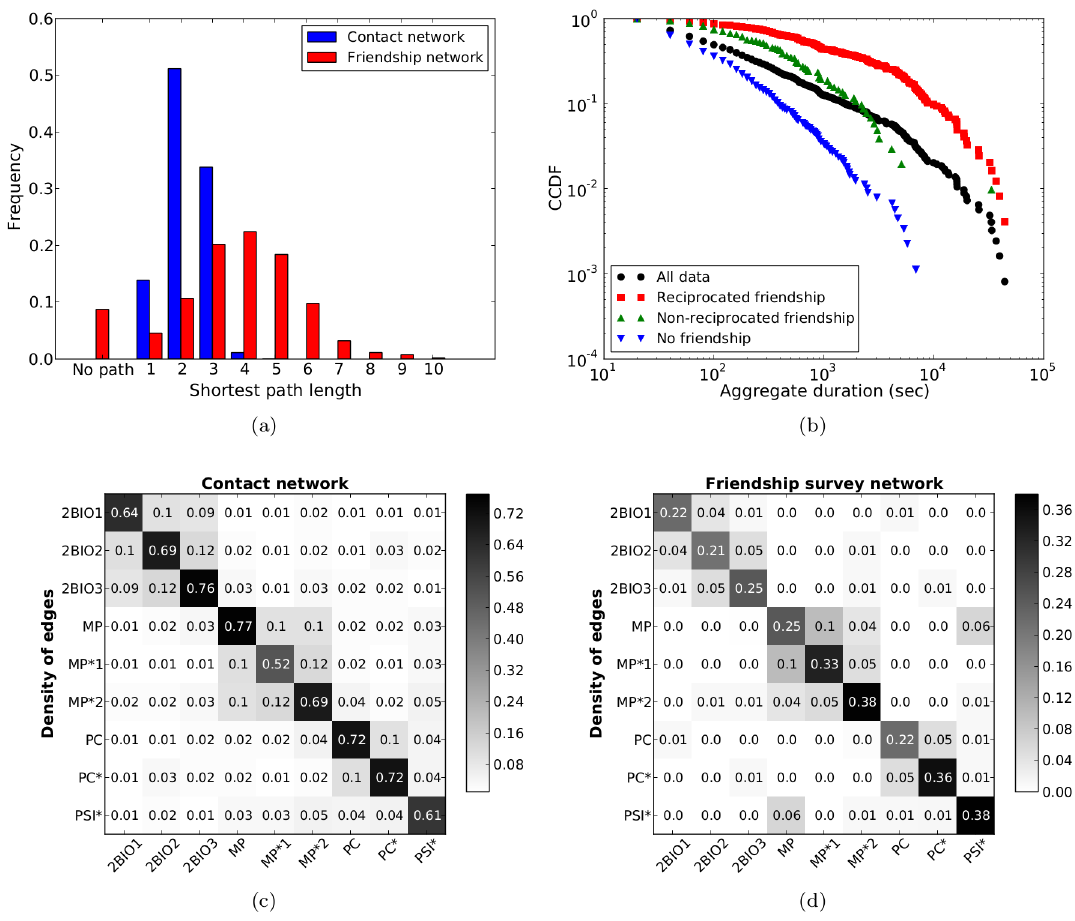
Fig 6. Comparison of the networks of contacts and friendships. (a) Shortest path length distributions for both networks; (b) Distributions of aggregate durations, as measured by the sensors, for different kinds of links in the contact network: (i) all links, (ii) links i − j for which only one of i or j reported a friendship with the other, (iii) links for which both students reported the friendship, and (iv) links for which no friendship was reported; (c) and (d): Contact matrices of link densities. We compare here the contact matrices of link densities built from (c) the global aggregated network of contacts obtained using the sensor data and (d) the symmetrized network of reported friendships. The similarity between these two matrices is (cid:3) 95%.